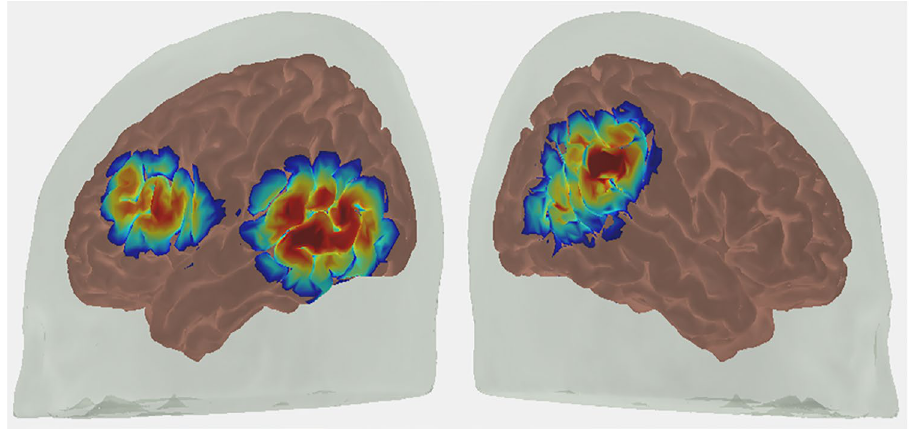
Figure 1. Sensitivity profile of fNIRS probe. Sources and detectors were placed over left frontal and bilateral temporal-parietal regions.